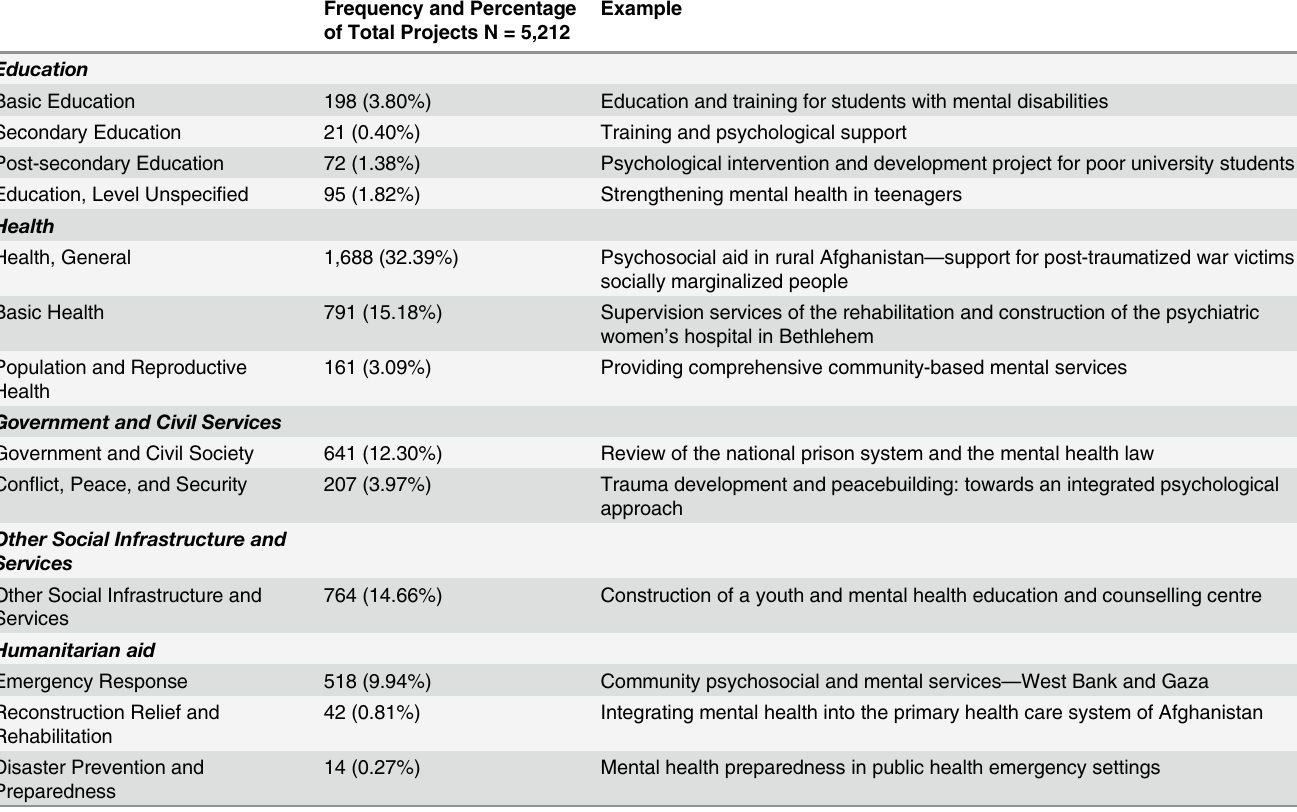
Table 1. Sectors for identifying mental health projects: Frequency and